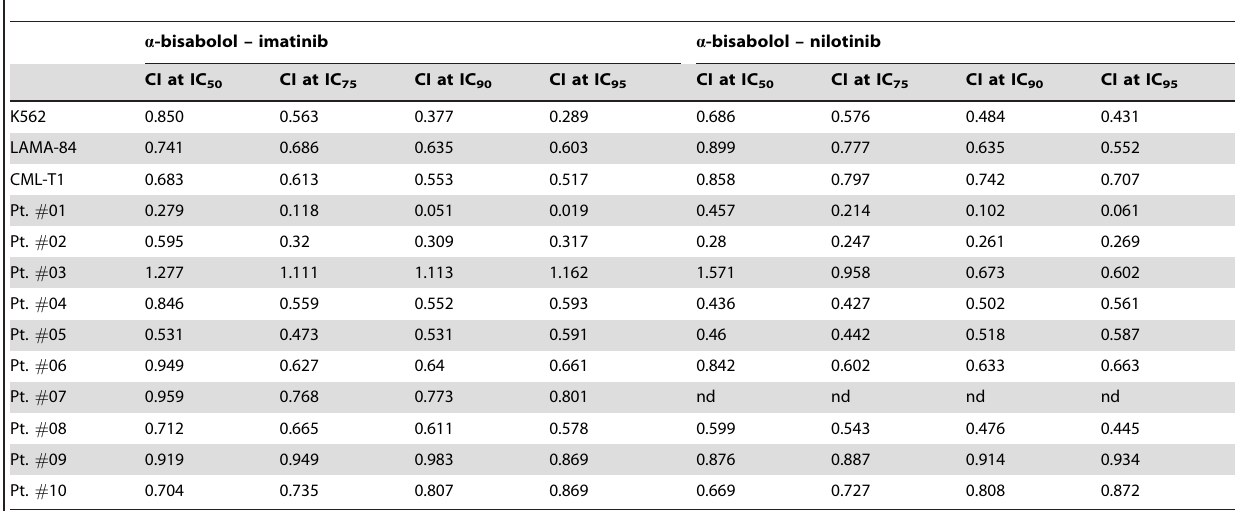
Table 1. Combination indices (CI) in synergysm experiments using drugs in constant ratio.